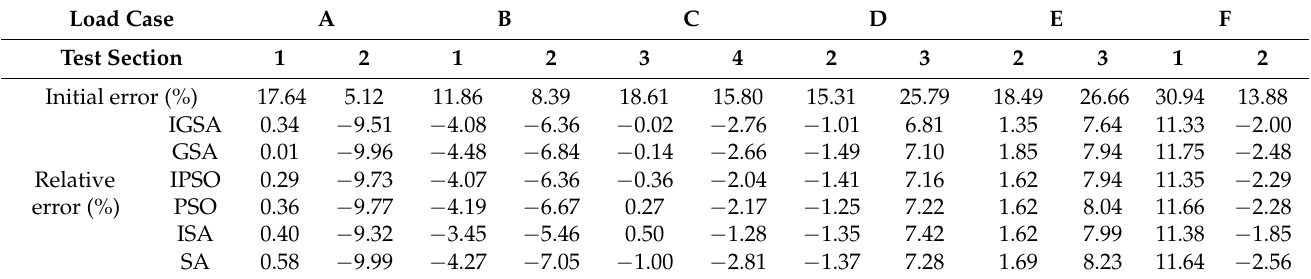
Table 8. Comparison of the displacement relative errors between the initial FE model and updated FE